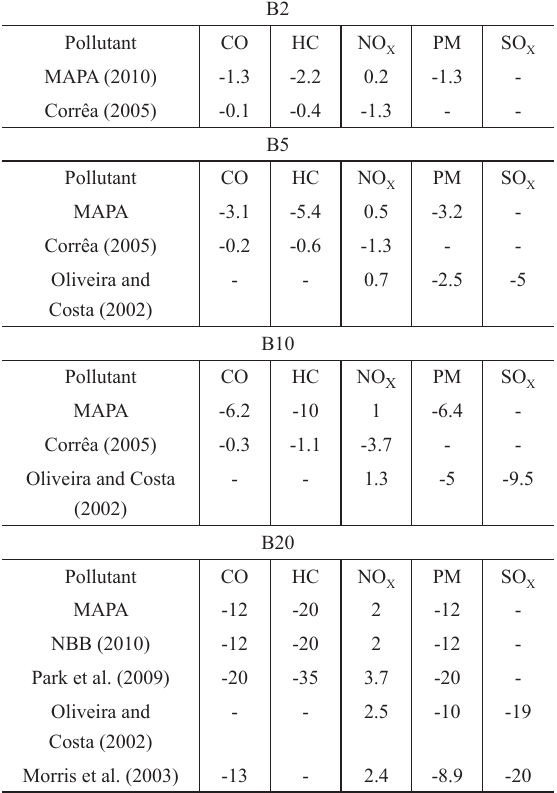
Compared results (%) of various studies on pollutant emissions from diesel oil added of different biodiesel